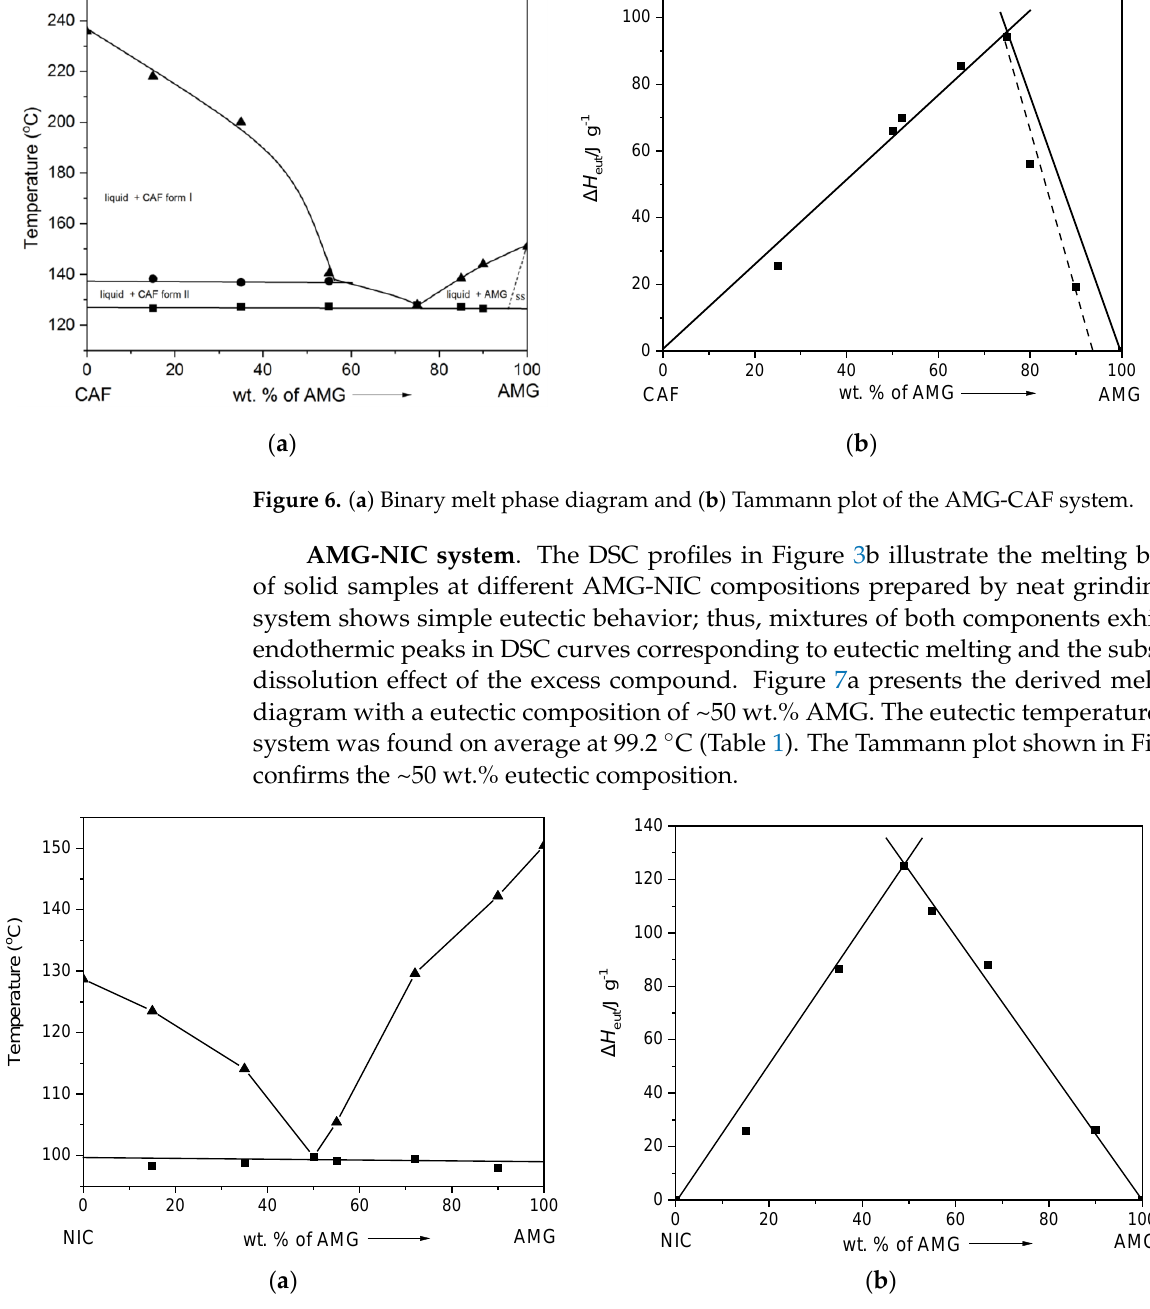
Figure 7. ( a ) Binary melt phase diagram and ( b ) Tammann plot of the AMG-NIC system. As for the AMG-NIC system, the melt phase diagram of the AMG-ZMD system is characterized by a simple eutectic, possessing a eutectic point at 101.8 °C and composition of ~50 wt.% of AMG. The eutectic composition was derived from the single endothermic event in the DSC thermogram and from the intersection of the ZMD and AMG liquidus curves. Tammann’s plot (Figure 8b) for the AMG-ZMD system verifies the eutectic composition close to 50 wt.% AMG and indicates partial miscibility at the solid-state close to the ZMD side (indicated by the dashed line in Figure 8b), but similar to the AMG-CAF system, which needs more detailed studies if important.